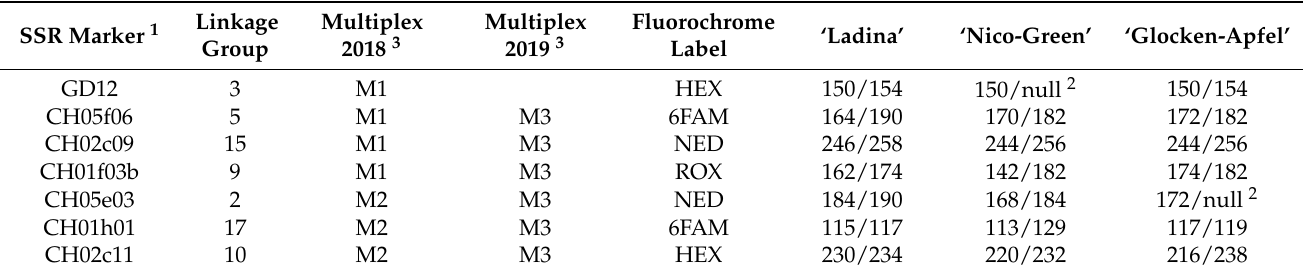
Table 1. SSR markers used in the study and relative allele composition of the apple cultivars ‘Ladina’, ‘Nicogreen’ and